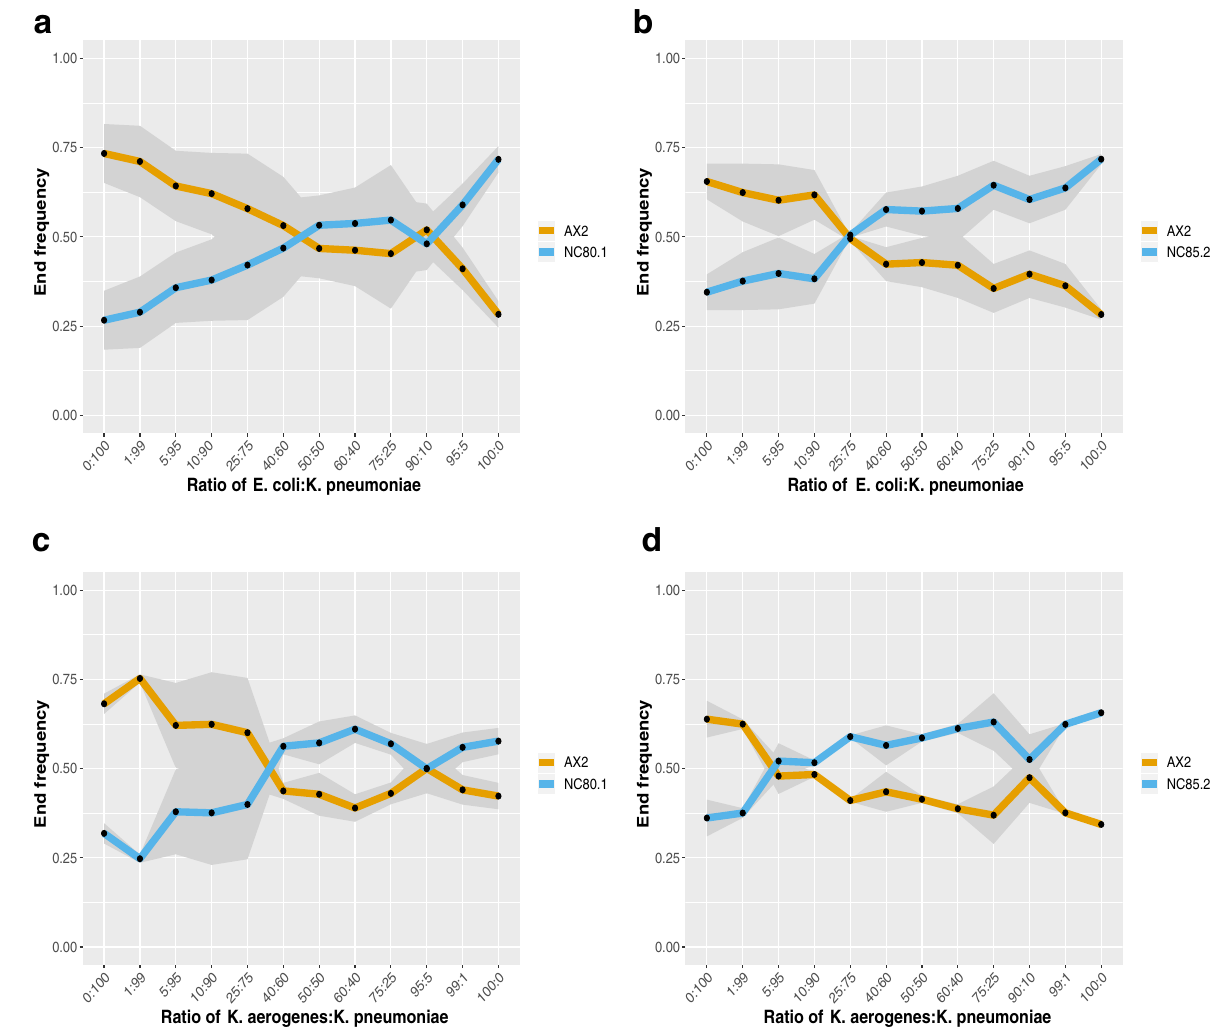
Fig. 2 Strains can coexist after short-term growth on prey mixtures. Competitions were performed between NC80.1 ( a , c ) or NC85.2 ( b , d ) with AX2- GFP at a starting ratio of 1:1 on plates containing varying proportions of either E. coli with K. pneumonia (A & B) or K. aerogenes with K. pneumonia ( c , d ). Cells were allowed to grow together in competition for 48 h (~10 generations of growth). The relative frequency of each strain was quanti fi ed at the start and endpoints of the competition by fl ow cytometry. Individual data points (black circles) represent mean values and the shaded area is the standard error from two independent experimental blocks. Source data are provided in the Source Data fi